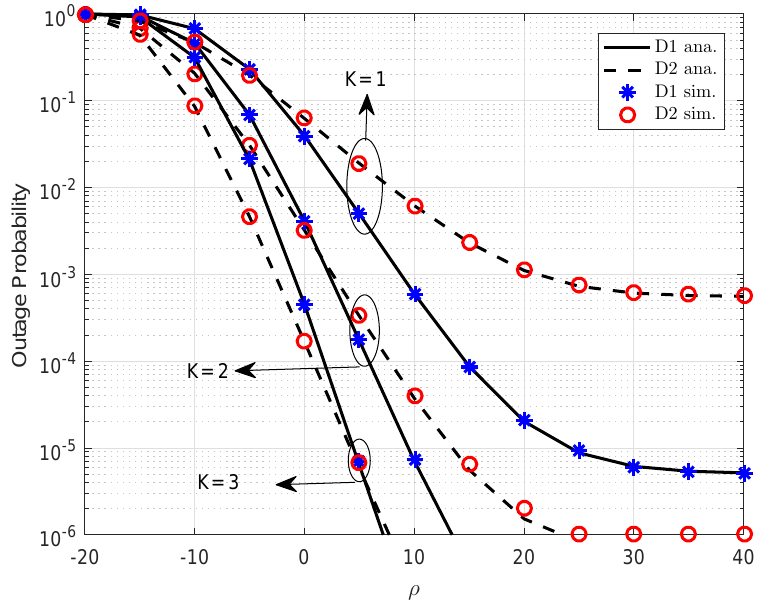
Figure 5. Outage performance of D 1 and D 2 as varying K